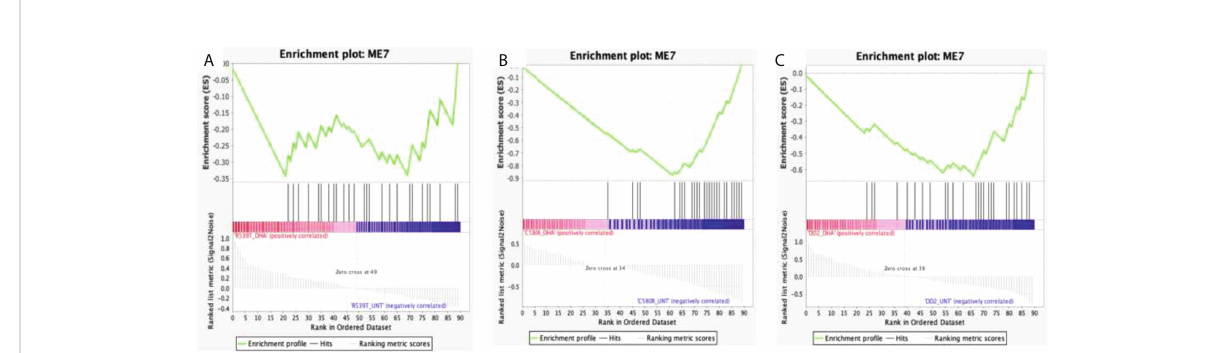
FIGURE 4 Enrichment score behavior showing the distribution of module 7 (ME0) in the input list of ranked genes for the three compared treatment conditions with FDR q-value < 0.25. Module 7 comprises 182 genes with correlated expression in P. falciparum . The enrichment plots were generated by GSEA. Enrichment scores (ES) were calculated by strolling down the input list of ranked of genes, increasing a running-sum statistic when a gene is in ME7 and decreasing it when it is not. The magnitude of the increment depends on the correlation of the gene with the treatment condition. The ES is the maximum deviation from zero encountered in walking the list. The normalized enrichment score (NES) is calculated by normalizing the enrichment score for gene set size and represents the association of the modules with the treatment conditions compared. A positive NES indicates module enrichment and association with the fi rst treatment condition and a negative NES indicates module enrichment and association with the second treatment condition. The higher the NES the stronger the association with the module. False discovery rate (FDR) was used to correct for multiple testing. Statistical signi fi cance was designated at an FDR q-value < 0.25. (A) R539T_DHA_treated versus R539T_untreated condition; ME7 was upregulated in the R539T_untreated condition (NES = -1.27, FDR q-value = 0.15). (B) C580R_DHA_treated versus C580R_untreated; ME7 was upregulated in the C580R_DHA_treated condition (NES = -2.43, FDR q-value = 0.0). (C) DD2_DHA_treated versus DD2_untreated; ME7 was upregulated in the DD2_untreated condition (NES = -2.24, FDR = 0.0). ME7, module 7; ES, enrichment score; NES, normalized enrichment score; FDR, False discovery rate; GSEA, gene set enrichment